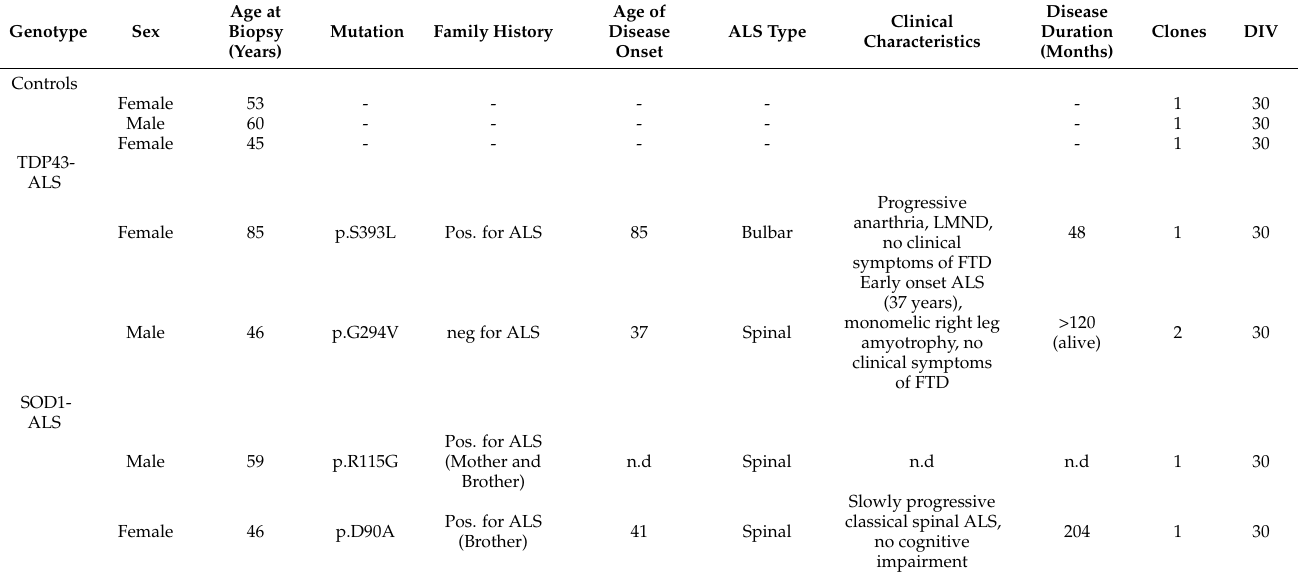
Table 1. Patient/proband